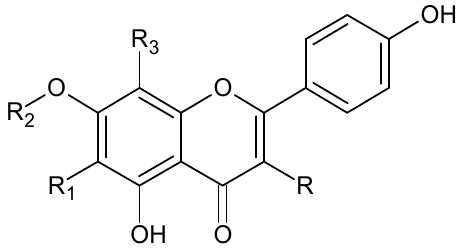
Figure 2. Kaempferol and kaempferol O -glycosides. Table 1 . Kaempferol and kaempferol O -glycosides.